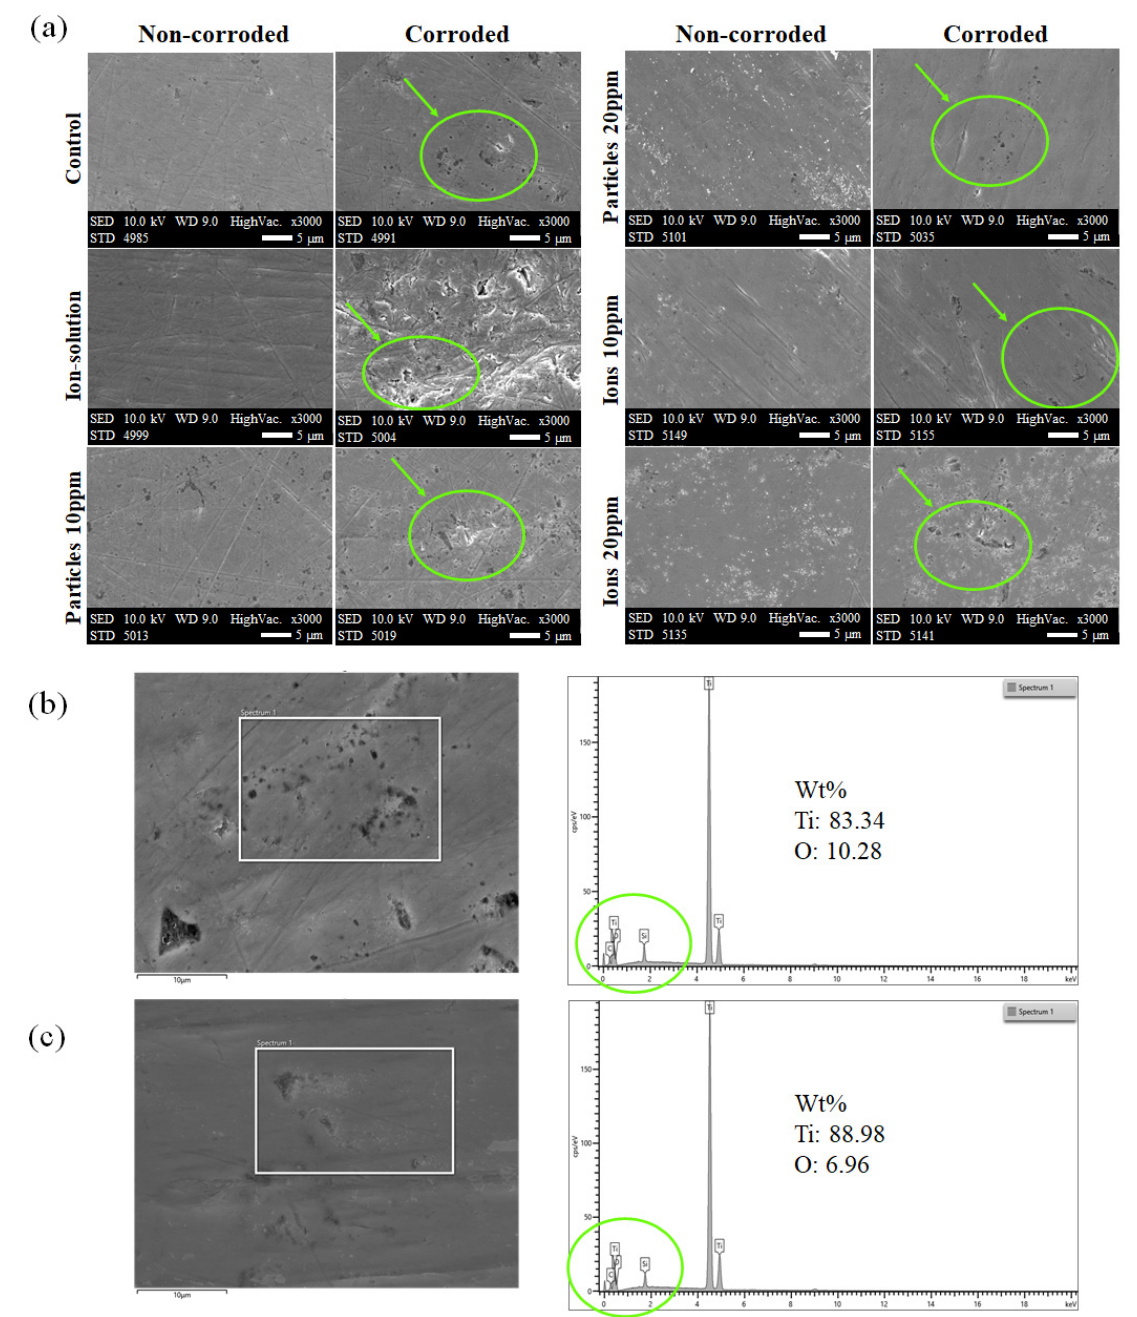
Figure 7. ( a ) SEM images of representative samples. The non-corroded areas are shown in the images in the left column and the corroded areas of the same samples are shown in the right column. The green circles and arrows indicate the surface irregularities caused by corrosion. EDS spectra of ( b ) control which show more oxygen indicating more passivation than ( c ) Ti-ion 20 ppm group.